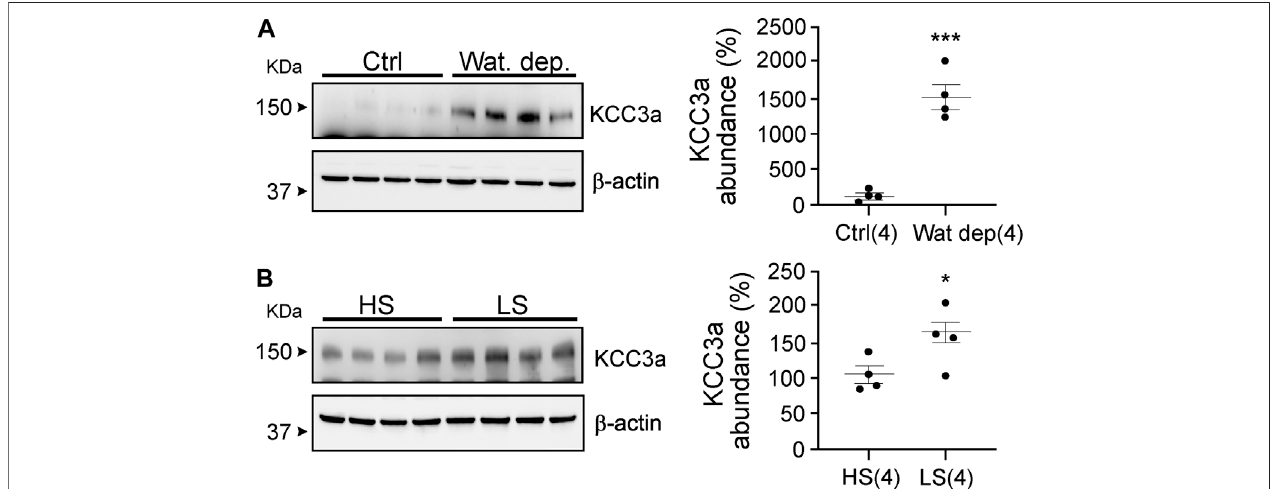
FIGURE 6 | Potassium chloride cotransporter 3a (KCC3a) abundance changes in response to water deprivation and high-saltversus low-salt diets. (A) Mice were water restricted for 23 h, (Wat. Dep.) and KCC3a abundance was compared to mice maintained on water during the same period Ctrl, (two-tailed unpaired t -test). (B)